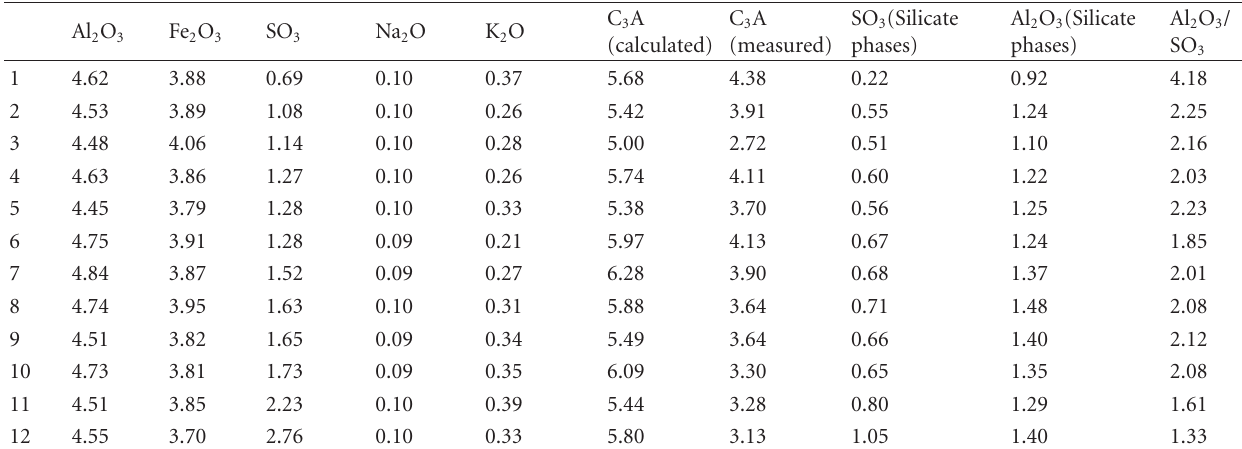
Table 1: Chemical and mineralogical analysis results.